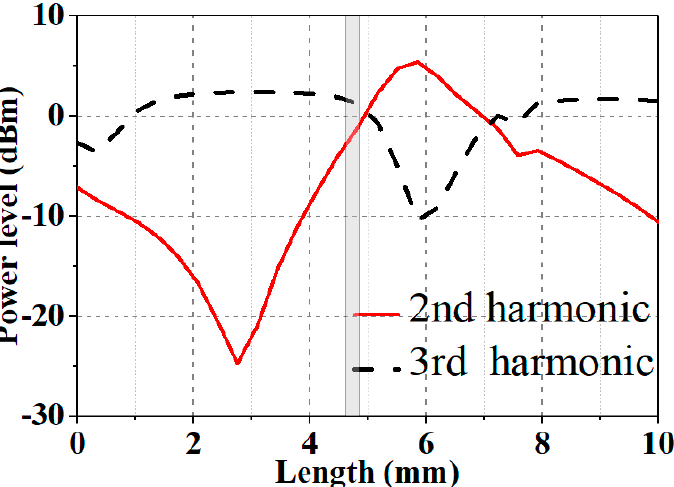
Figure 4. Simulated harmonic amplitude with the length of the stub l 10 at 18 dBm input power. Figure 5 analyzes the rectifying efficiency and harmonic amplitude of different rectifier at different input power. Figure 5a–c have different circuit layouts and the main difference between them is the input impedances of the DC-pass filter at harmonics. The layouts of them are all realized through π -type stub and the DC-pass filter composed of five open stubs, but their sizes are different to realize different harmonic utilize states. Figure 5d is the convention harmonic suppression rectifier, and the simulation results are described here for comparison with Figure